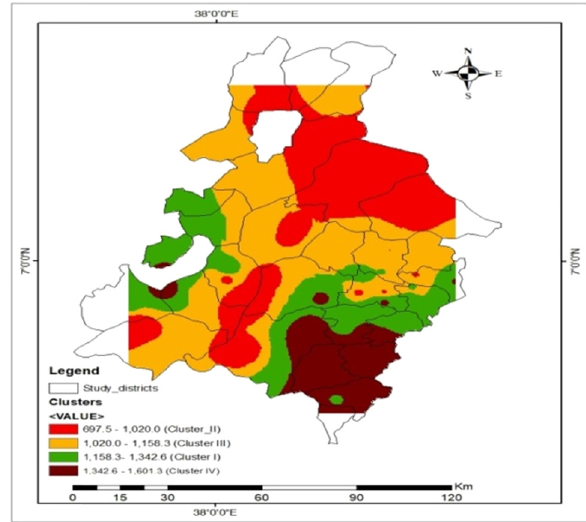
Figure 7: The location of the four